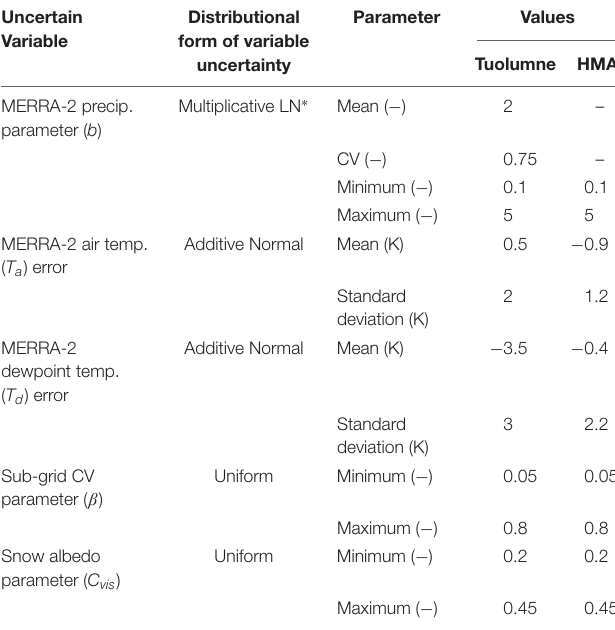
TABLE 1 | Parameters used in the specification of prior uncertainty in key snow model inputs.